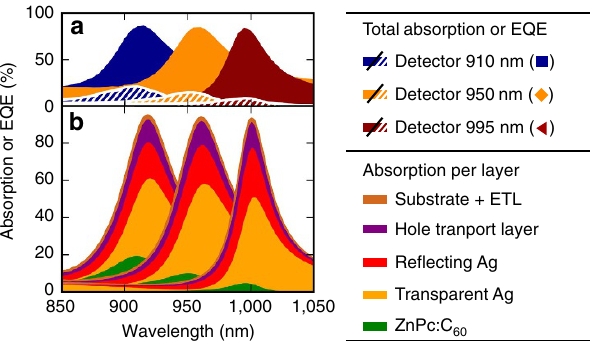
Figure 4 | Identification of parasitic absorption at the resonance wavelength. Three ZnPc:C 60 devices from Fig. 2a with resonances at 910nm ( ’ ), 950nm ( ~ ), and 995nm ( b ) are analysed. ( a ) The experimental device absorption is shown as filled area and the corresponding EQE as hatched area. ( b ) The simulated absorption is estimated for each layer. The legend entries are given in the order of appearance.